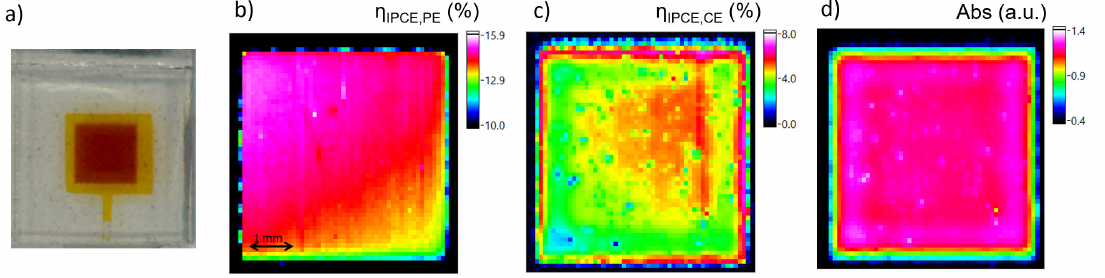
Figure 5. ( a ) Photo of the DSC with 0.25 cm 2 of active area. Spatial maps of ( b ) IPCE PE , ( c ) IPCE CE and ( d ) absorbance acquired at λ = 530